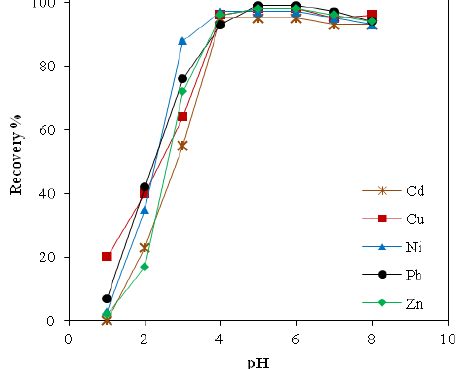
Figure 1. Effect of pH on metal ions adsorption. Other conditions: 30 mg of the sorbent, shaking time 30 min, temperature 25  C, sample volume 10 mL.